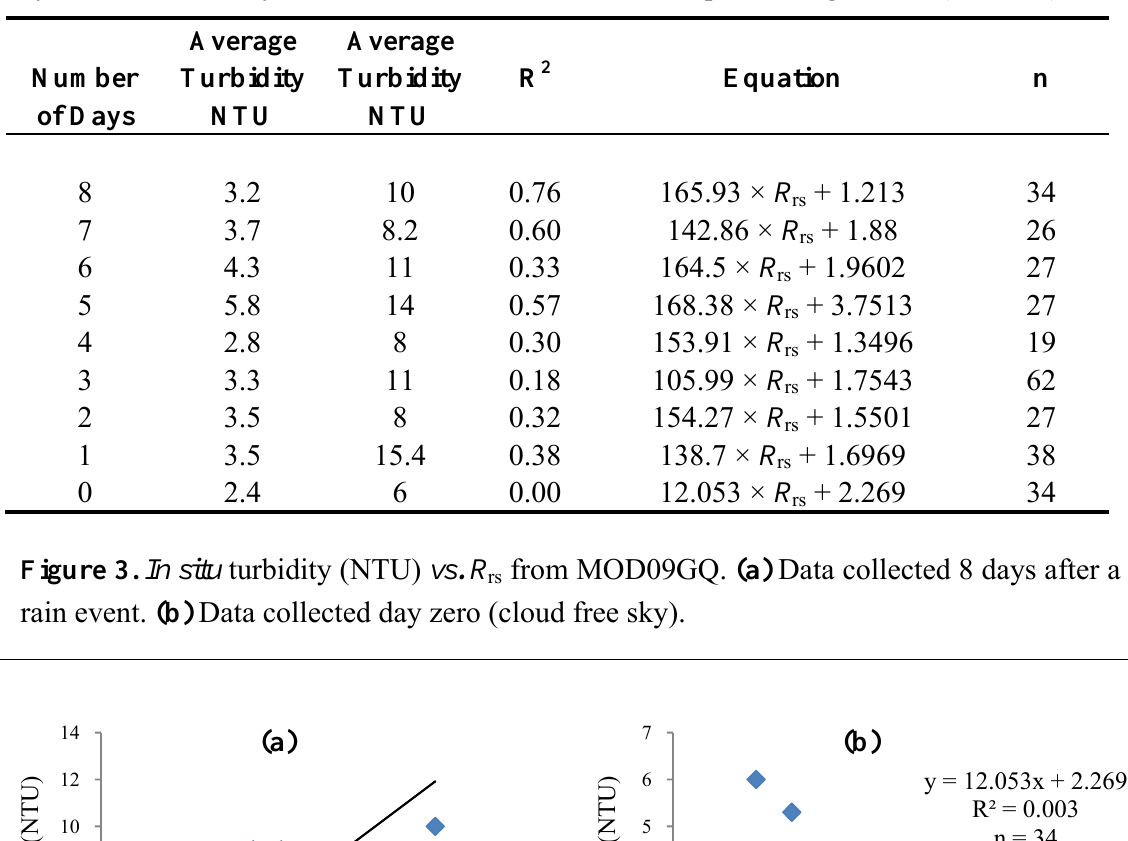
from MOD09GQ, separated rs